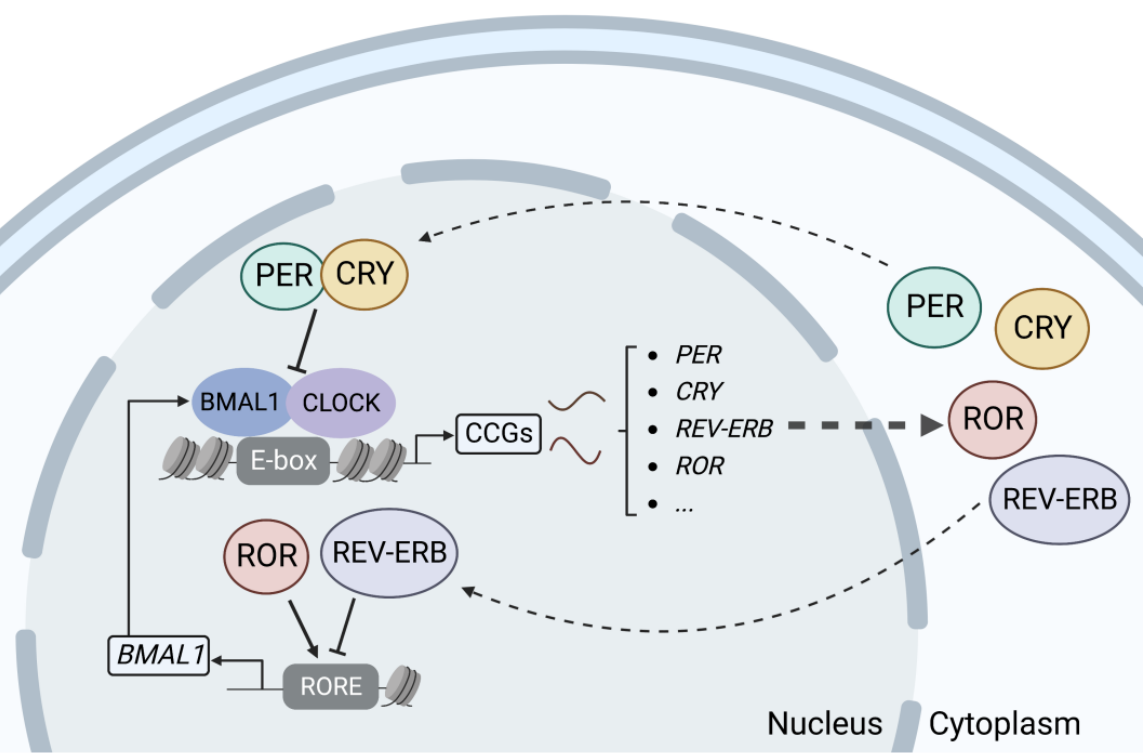
Figure 1. Feedback loops of transcription and translation in the circadian clock system. (Created with BioRender.com)